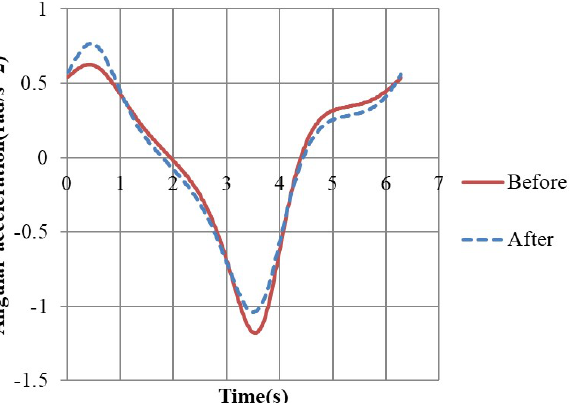
Figure 15. The angular acceleration α 6 of the passenger side output-link of CDLS before/after DE optimization.